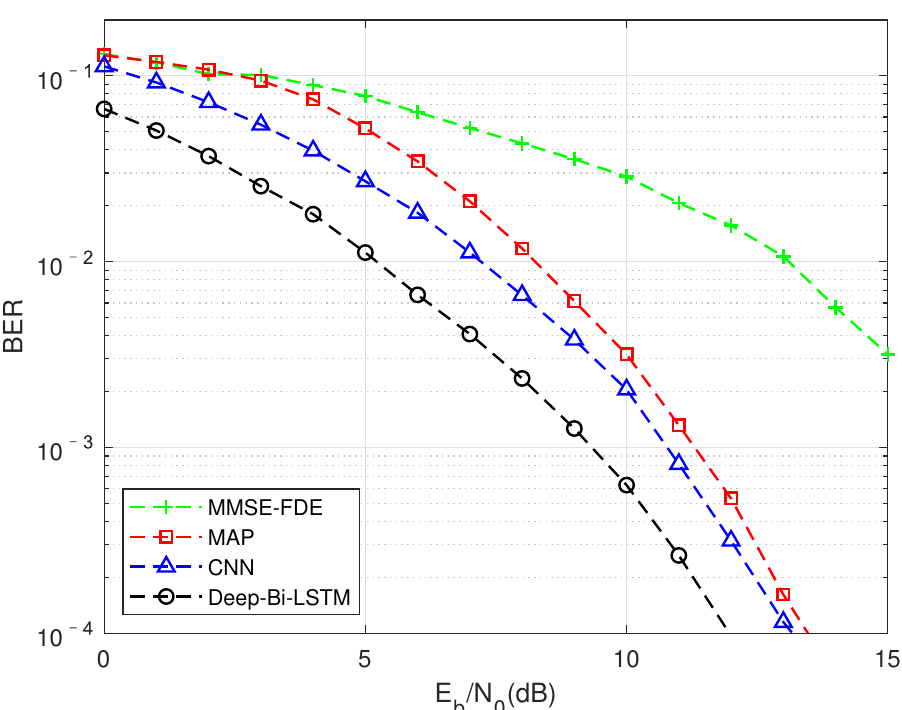
Figure 5. FTN detection performance results of different algorithm in the TU channel, MMSE equalization, and the compression factor τ =